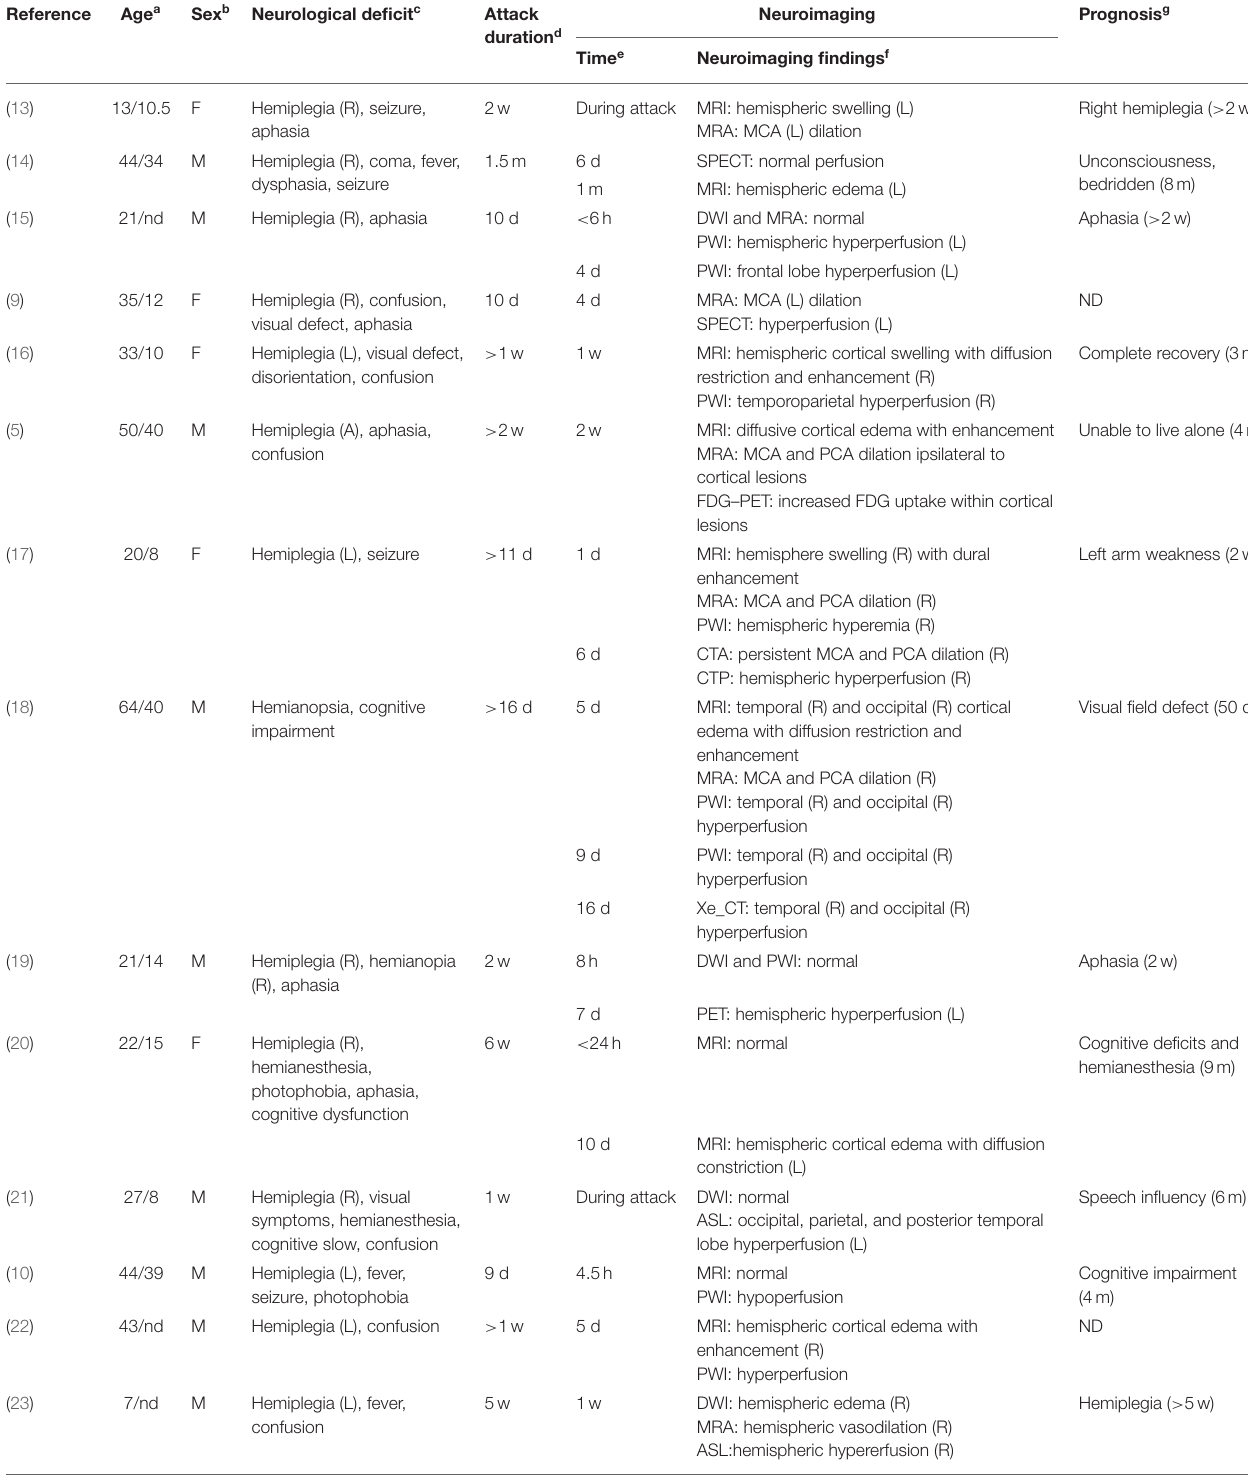
a Age at attack/age at HM onset; nd, not described. b M, male; F, female. c R, right; L, left; A, alternating. d h, hour; d, day; w, week; m, month. e Time after attack onset. f DWI, diffusion-weighted imaging; MRA, magnetic resonance angiography; PWI, perfusion-weighted imaging; ASL, arterial spin labeling MRI; Xe_CT, xenon_CT; SPECT, single photon emission computed tomography; FDG, fluorodeoxyglucose; PET, positron emission tomography; MCA, middle cerebral artery; PCA, posterior cerebral artery. g Residual symptoms (persistent duration).